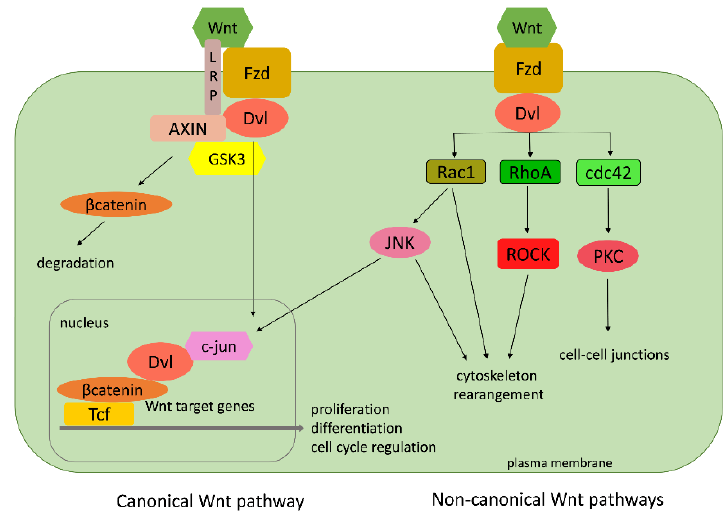
Figure 12. A simplified representation of the canonical and non-canonical Wnt signaling pathway.